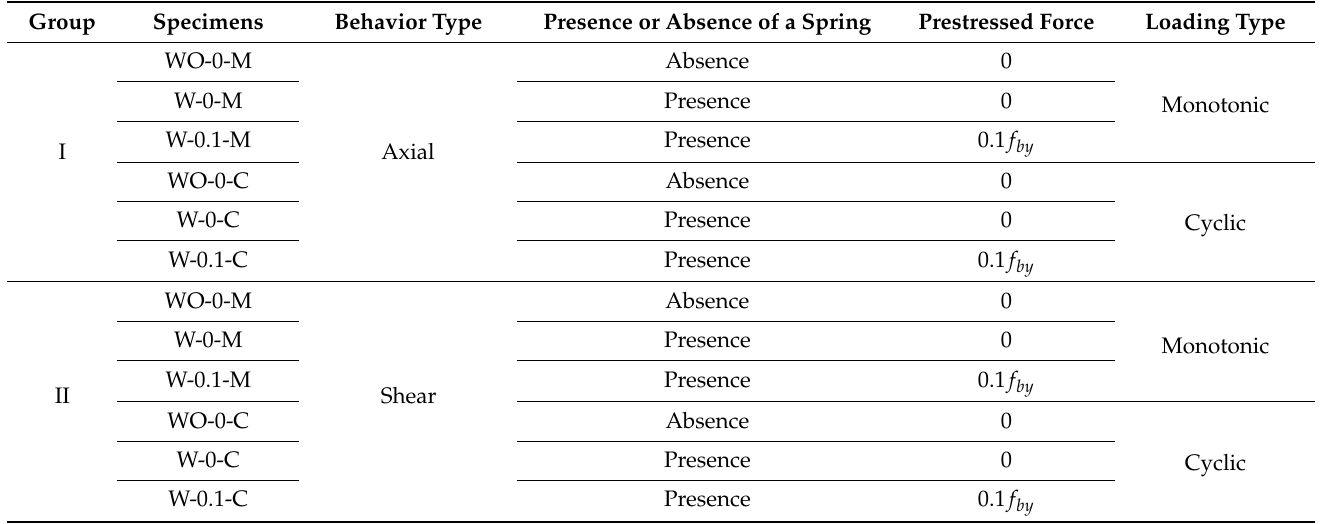
Table 1. Details of SDI specimens.